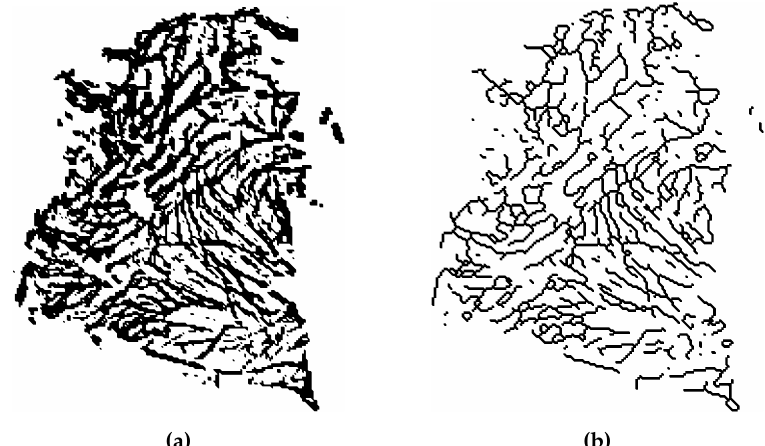
Figure 3. Image segmentation: ( a ) Segmentation result ˆ B ; ( b ) Result of thinning B